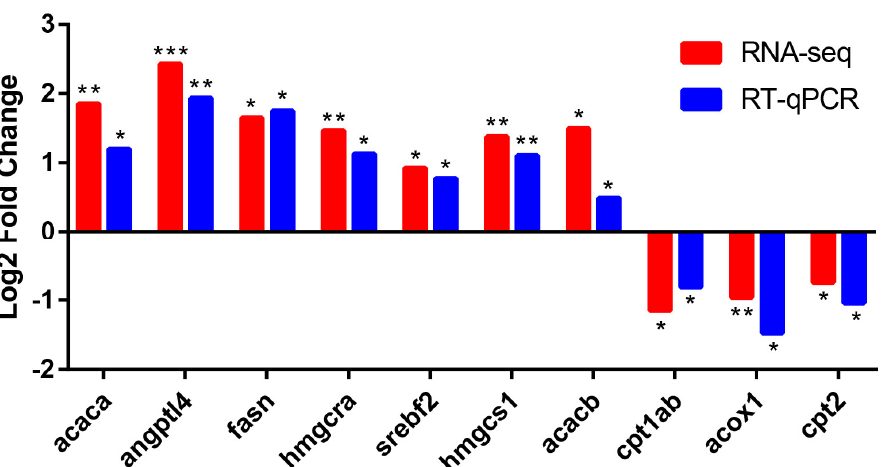
Figure 6. Comparison of RNA-seq data with RT-qPCR data. The x -axis shows the names of genes, and the y -axis indicates the Log 2 (Fold Change) with the relative expression (compared to the control group) of each gene. * p -value < 0.05 compared with the control group. ** p -value < 0.01 compared with the control group. *** p -value < 0.001 compared with the control group.